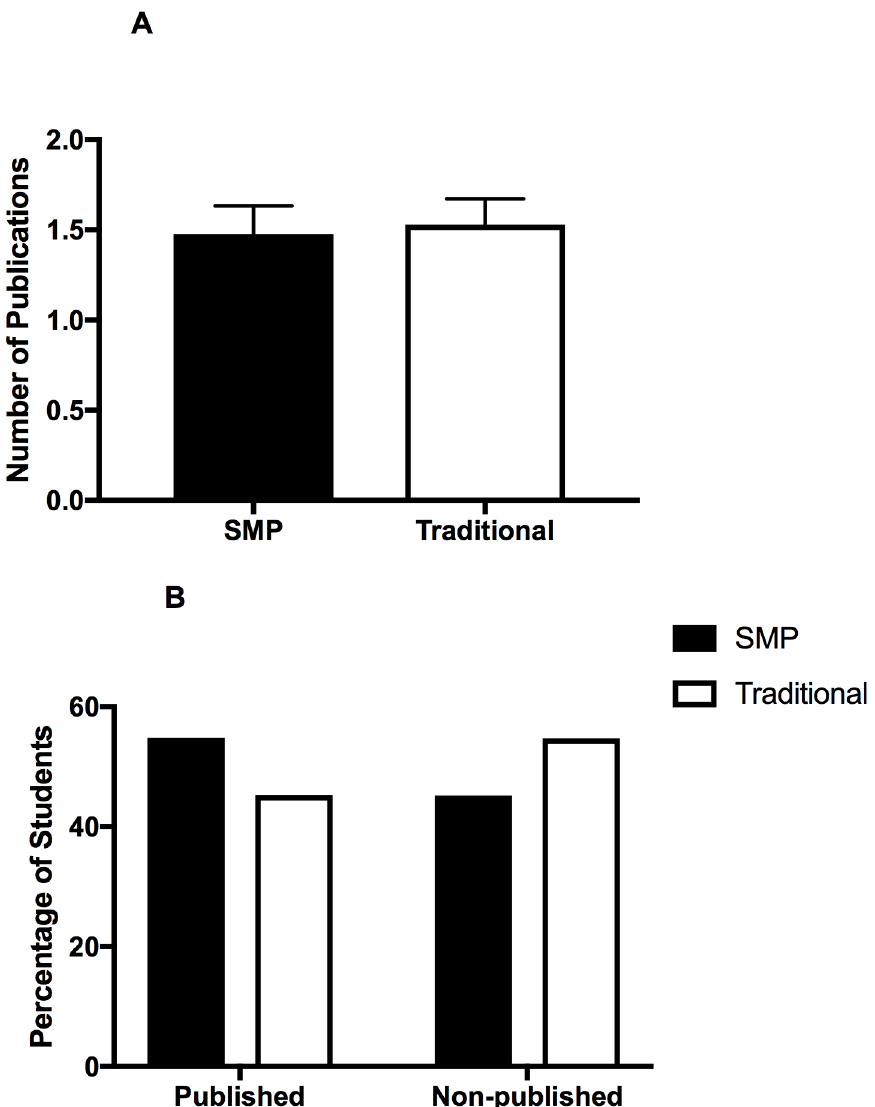
Fig 4. A. Comparative Analysis of Number of PublicationsbetweenSMP and TraditionalStudents. Comparative analysisusing an unpairedt test shows no significantdifference in the numberof publications produced by SMP (mean = 1.48 (0.16 SEM), n = 42) vs. Traditional Students (mean = 1.53 (0.14 SEM), n = 51). B. ComparativeAnalysis of Percentageof Published and Non-PublishedSMP and Traditional Students. Chi Square analysisof students with at least one publication shows no significantdifference betweenSMP (54.84%, n = 62) and Traditional Students (45.26%, n = 95).